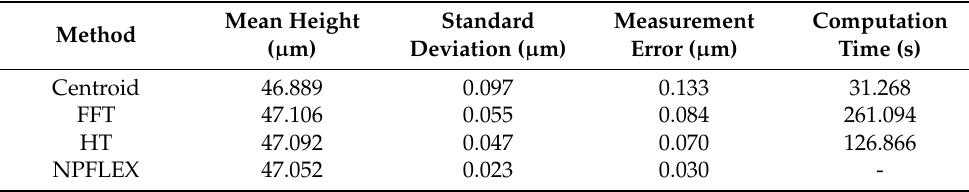
Table 3. Measurement results of 47.022 µ m step Table 2. Measurement results of 7.347 μ m step height.